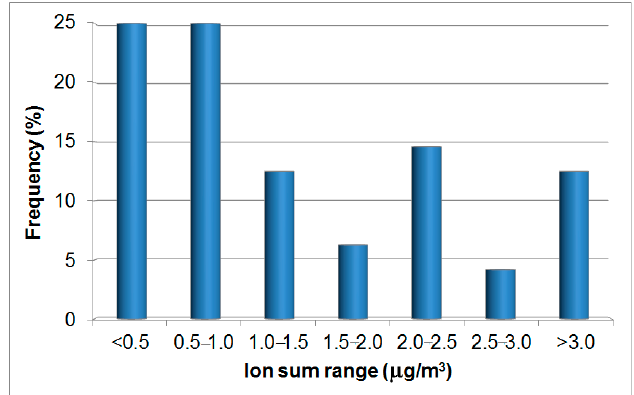
Figure 6. The frequency of the average concentrations the sum of ions in the composition of the atmospheric aerosol in the near-water atmospheric layer above Lake Baikal from 2010 to 2019.